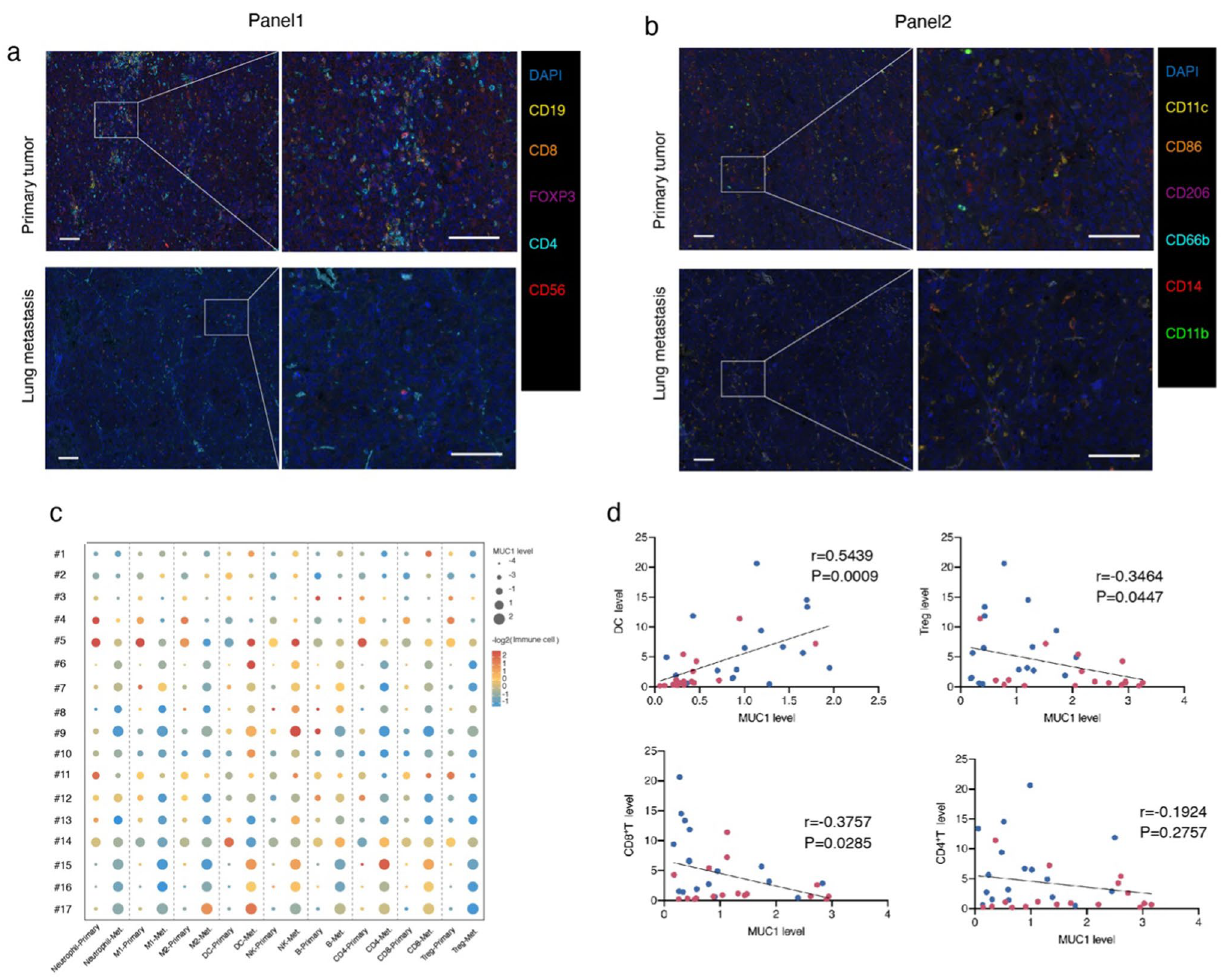
and myeloid immune cells. Representative mIHC staining images of metastasis-associated a lymphatic and b myeloid immune cells. Scale bars, 50 μm. c Dot plots displaying MUC1 expression level and altered immune cells in paired primary tumors and lung metastases. d Cor- relation analyses between MUC1 and metastasis-associated immune cells. *P < 0.05, **P < 0.01, ***P < 0.001, by Pearson correlation